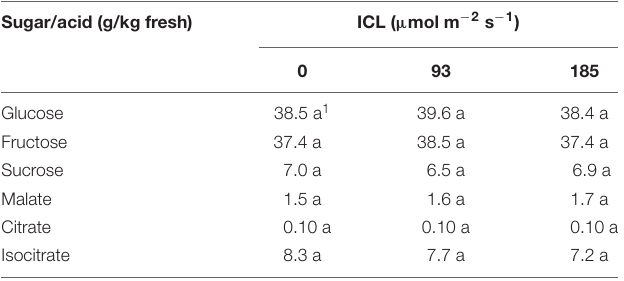
1 Different letters within rows indicate significant difference according to Fisher’s protected LSD-test (P = 0.05); n = 6.